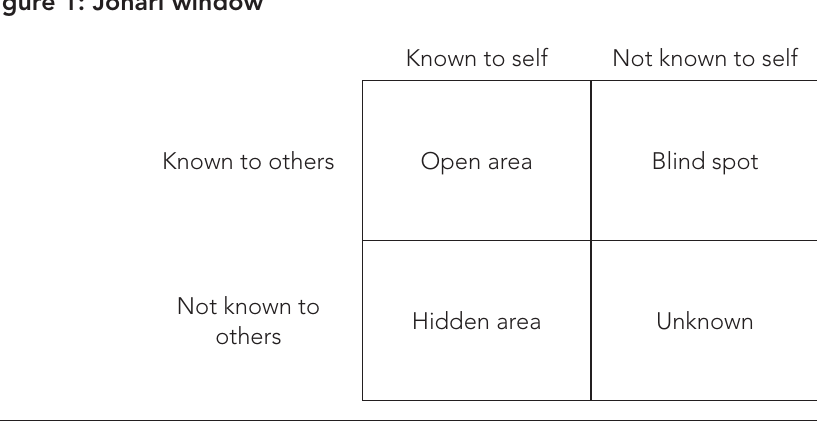
Known to self Not known to self